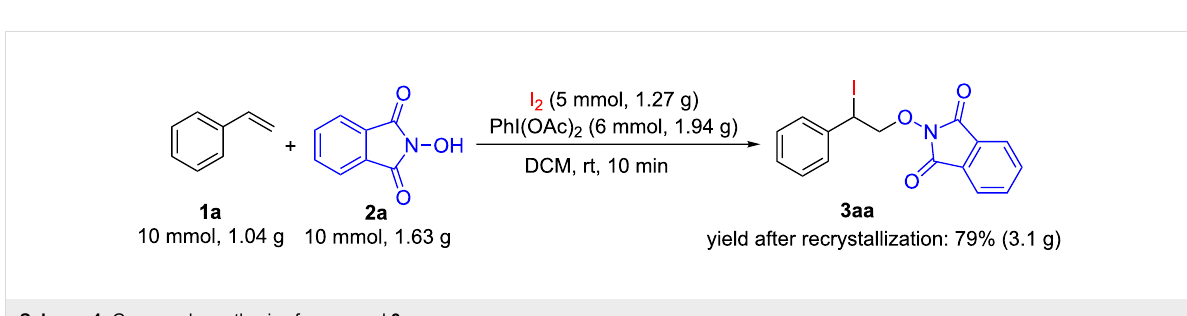
Scheme 4: Gram-scale synthesis of compound 3aa .